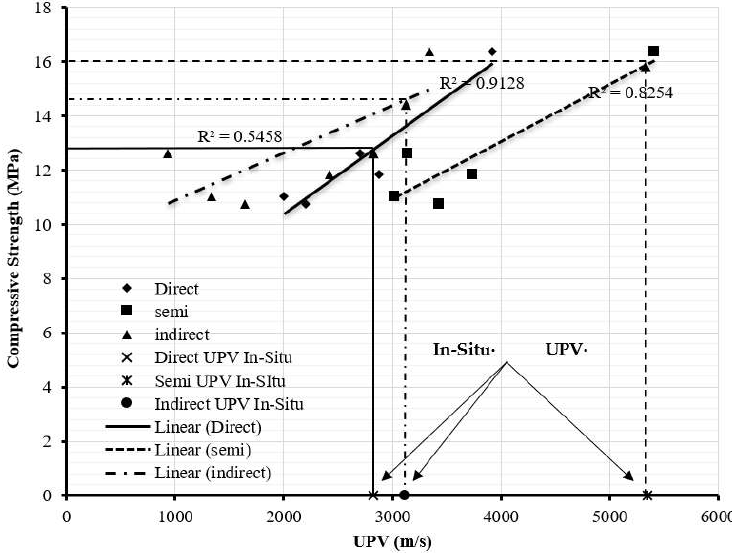
Figure 19. Compressive strength vs. UPV for Umar Hall.